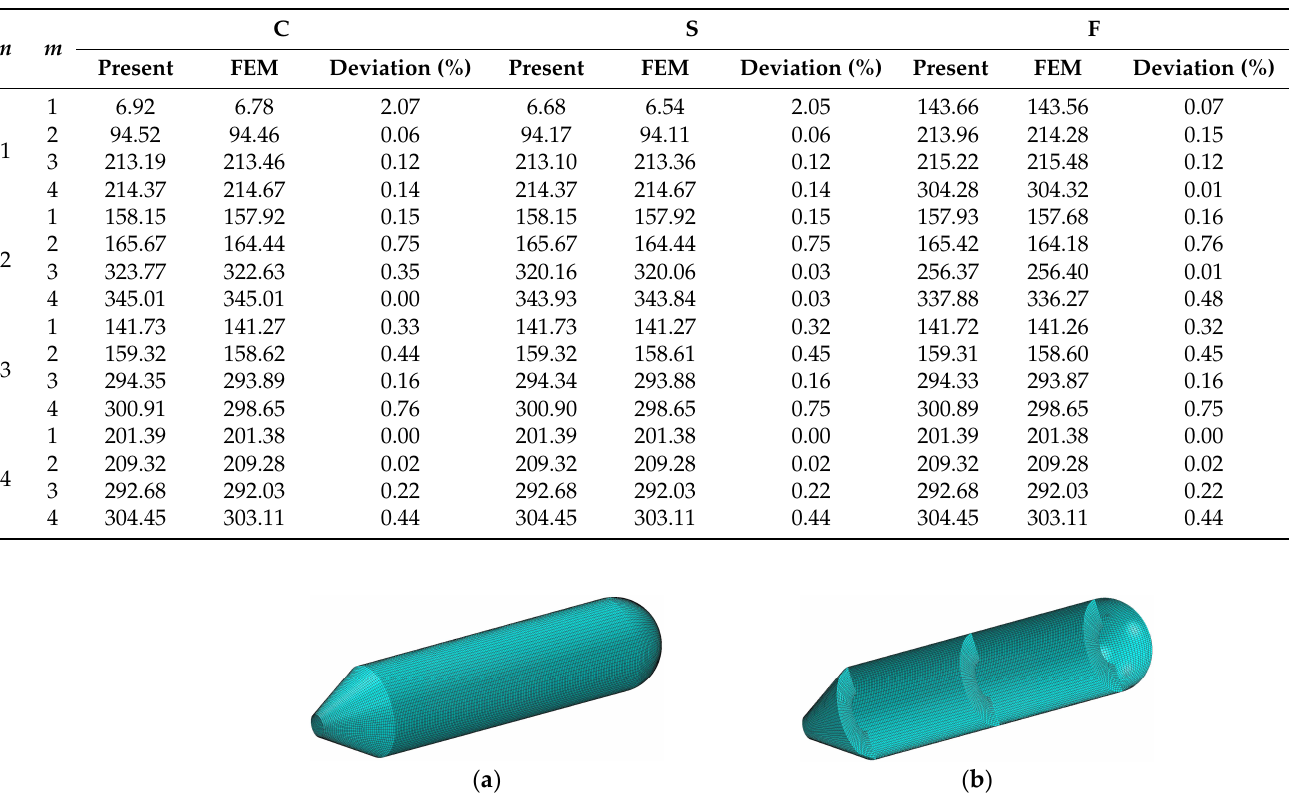
Table 2. Comparison of calculation frequency of laminated submarine-like structure under various boundary constraints.